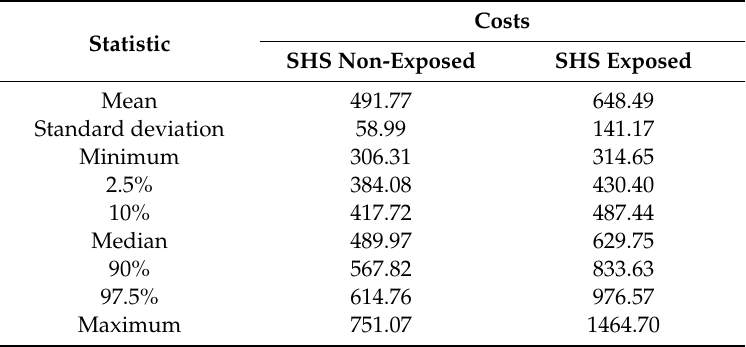
Table 5. Summary of the probabilistic sensitivity analysis